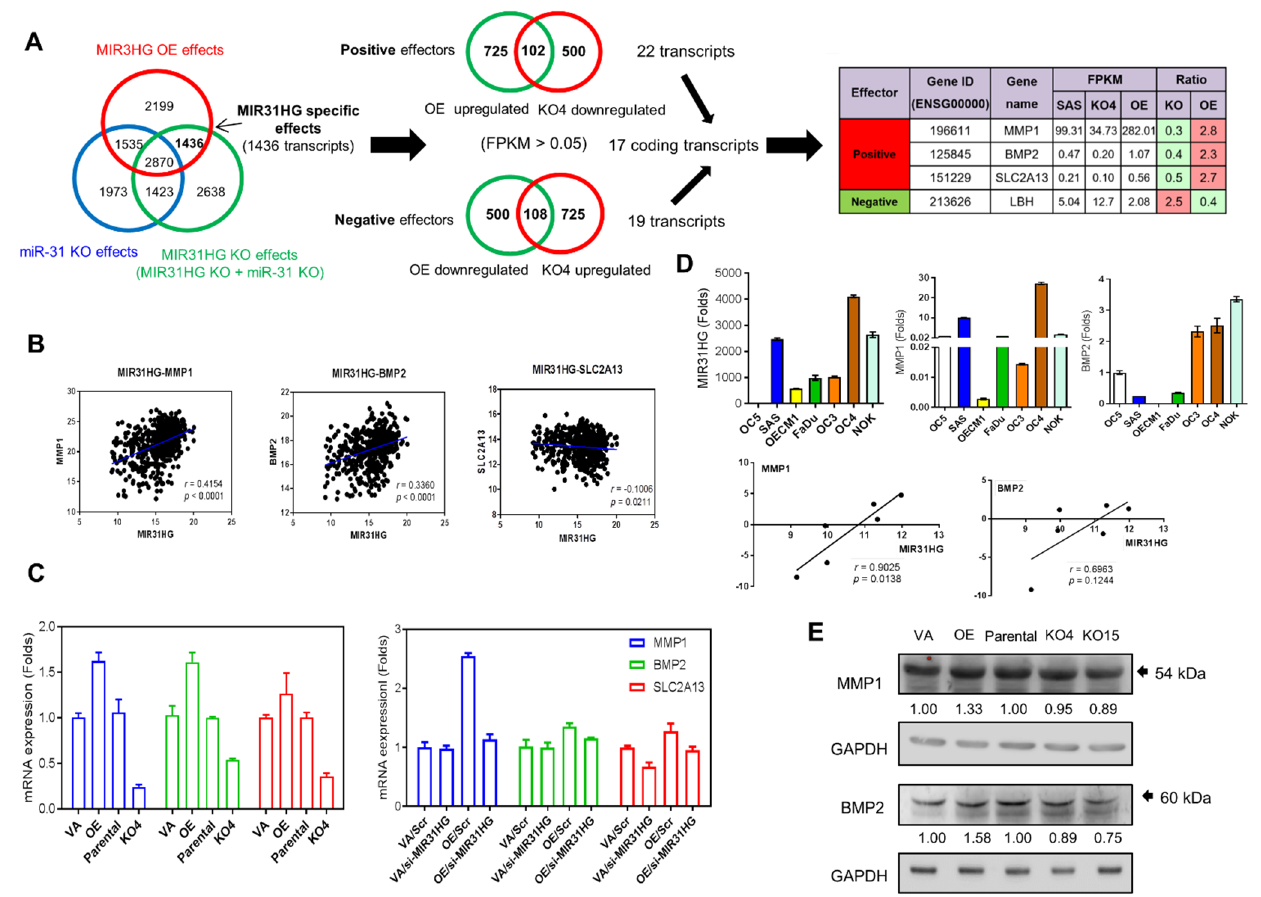
Figure 5. Identification of potential MIR31HG effectors in SAS cells. ( A ) The strategy using RNASeq data. Left, the identification of MIR31HG specific effectors. Middle, the identification of 22 positive and 19 negative effectors potentially modulated by MIR31HG . Specifically, 17 coding transcripts were potentially modulated by MIR31HG . Right, the expression profile of MMP1 , BMP2 , SLC2A13 , and LBH, the genes selected for further analysis. ( B ) The correlation between MIR31HG expression and the expression of MMP1 , BMP2 , and SCL2A13 in HNSCC tumors of the TCGA dataset. ( C ) qRT-PCR analysis reveals that the level of MMP1 , BMP2 and SCL2A13 mRNA expression in SAS cells with either MIR31HG overexpression or MIR31HG deletion (left), as well as in cells that had been treated with si- MIR31HG or scramble (right). ( D ) Upper, qRT-PCR analysis to show MIR31HG , MMP1 , and BMP2 mRNA expression levels in various OSCC cell lines. Lower, a correlation is found between the expression of MIR31HG and MMP1 , but not between MIR31HG and BMP2 . ( E ) Western blot analysis. This shows an increase in MMP1 and BMP2 expression in stable cells with exogenous MIR31HG overexpression, and slightly decreased MMP1 and BMP2 expression in MIR31HG knockout cell subclones. VA or va, vector alone. OE, stable MIR31HG overexpression. oe, transient MIR31HG overexpression. Scr,